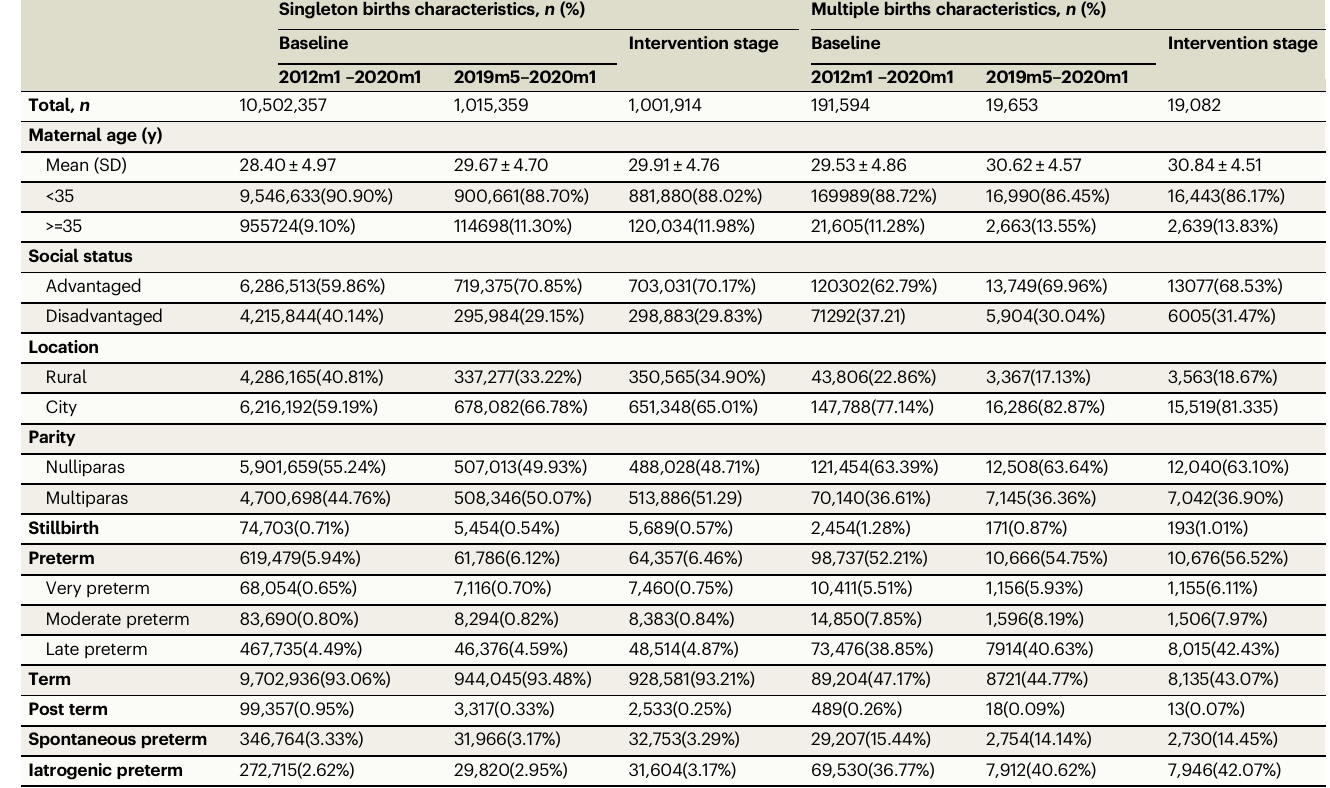
Table 1 | Maternal sociodem graphic characteristics by intervention in China, 2012 – 2020 ( N = 11,714,947) Singleton births characteristics, n